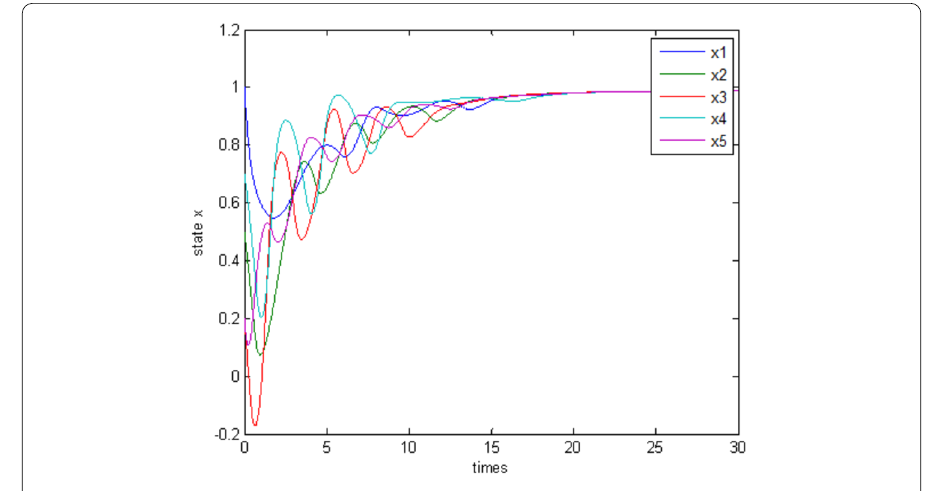
Figure 2 State trajectories of all the agents